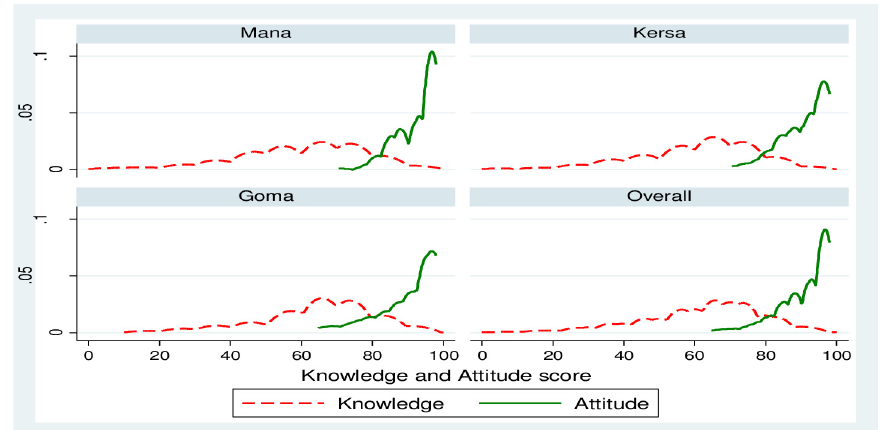
Fig 1. Kernel density estimates for malaria related knowledge and attitude scores by district, Jimma, Jan 2014. Overall, the density of knowledge score was lower as compared to the attitude score and in each district similar pattern was observed. This means despite low level of knowledge, the majority of the respondents had quite high favorable attitude towards malaria preventive measures (overall estimated mean = 91.5, Std Err = 0.6, 95% CI: 90.1 – 92.9%) towards malaria preventive measures. Generally, no single respondent scored less than 60% on the attitude scale. In contrast, there were respondents who had low level of knowledge (estimated mean = 62.2, Std Err = 0.7, 95% CI: 60.6 – 63.8%) on malaria and its preventive measures.